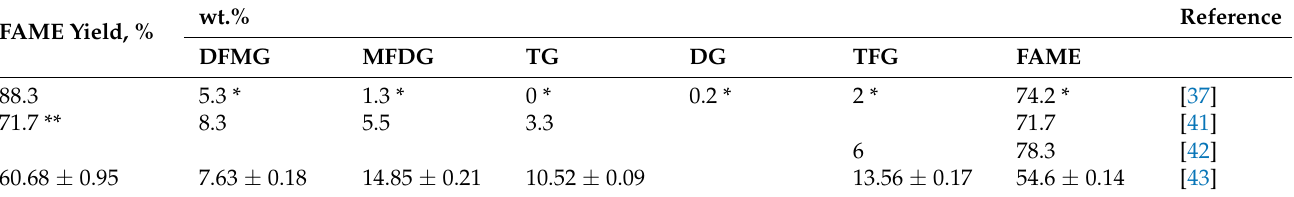
Table 2. Percentage composition of reaction